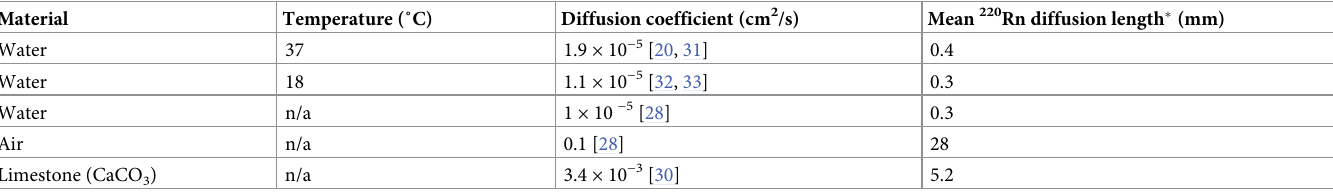
Table 3. Overview of radon diffusion coefficients and resulting mean diffusion lengths in different